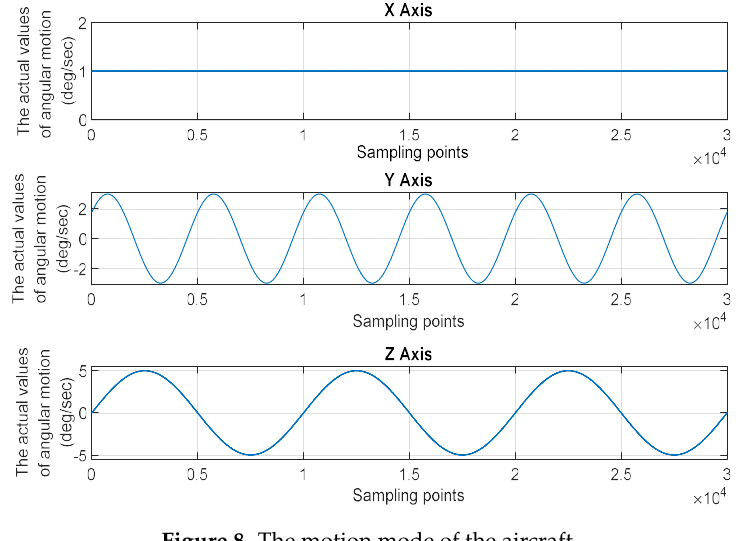
Figure 8. The motion mode of the aircraft.